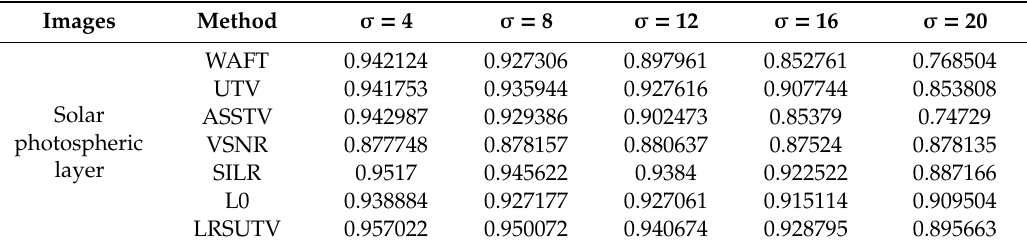
Table 4. SSIM of denoising results of various methods for solar granular.